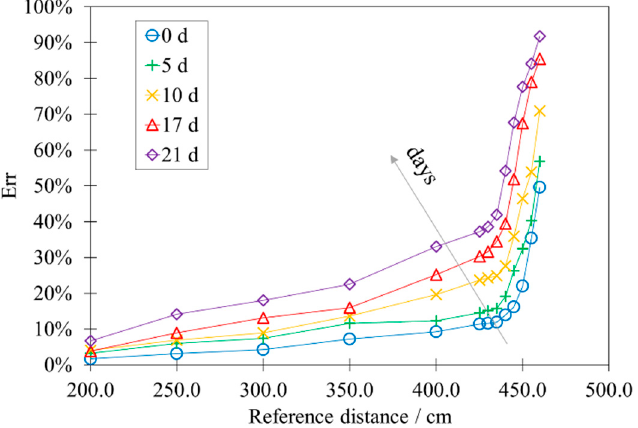
Figure 10. Influence of the accelerated aging on the percentage error Err .